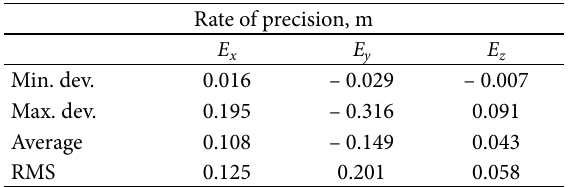
Table 4 . Coordinate deviations of photo triangulation points Points No.